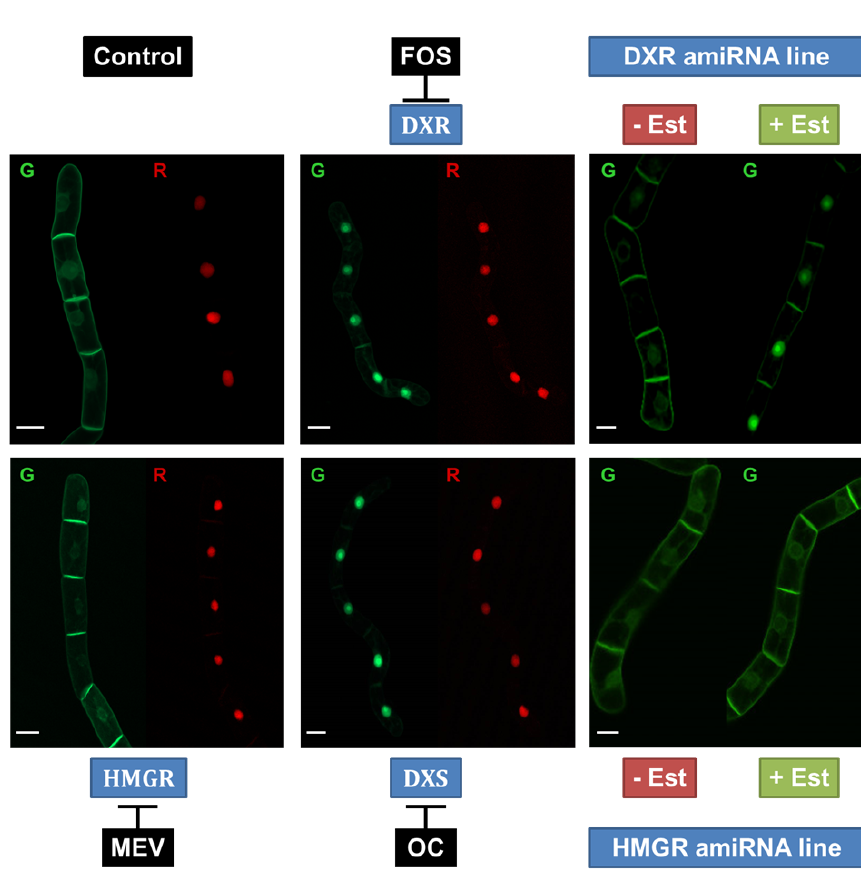
Figure 10. Two-channel imaging of the N-20 cell line after various treatments. The cell line was treated with different inhibitors affecting the MVA pathway (mevinolin) and the MEP pathway (fosmidomycin, oxoclomazone). Induction of the cell line with Est and Dex was carried out 24 h before observation. The cell line was treated with specific inhibitors 18 h before observation. Fosmidomycin ( FOS ) and oxoclomazone ( OC ) clearly shifted the localization of the GFP fusion protein to the nucleus, whereas mevinolin ( MEV ) treatment had no visible effect on the cells. In addition, we used two new cell lines with artificial micro interfering ( amiRNA ) silencing constructs as “biological controls”. (These cells expressed only the GFP reporter protein under the control of the dexamethasone-inducible promoter besides the amiRNA constructs.) For instance, DXR -silenced cells show the same phenotype as those inhibited in vivo by Fos. HMGR silencing however does not exert any visible effect on the localization of the GFP fusion protein. White bars represent 20